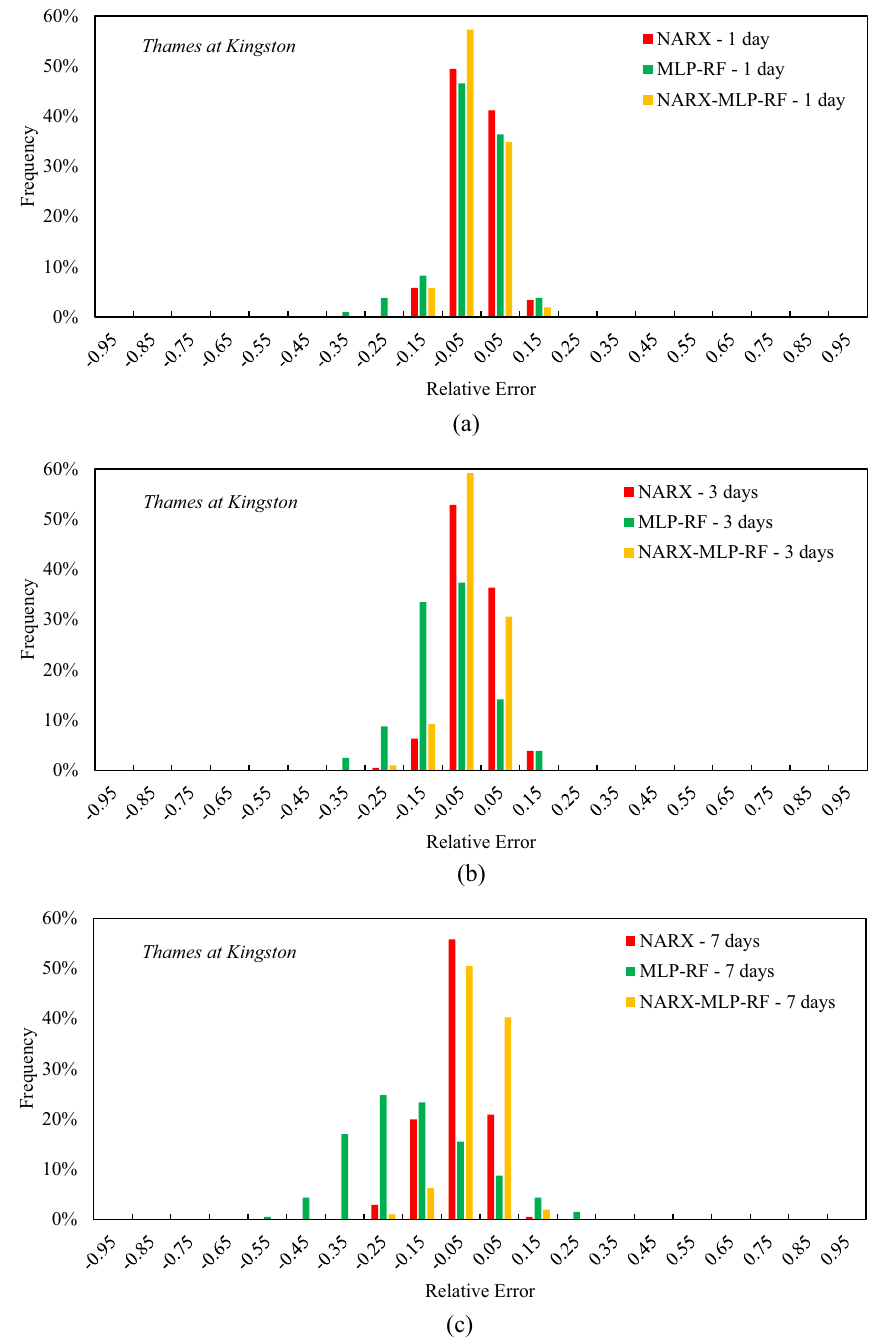
Figure 13. Frequency of the relative error for the tenth decile for Thames at Kingston: t = 1 day ( a ); t = 3 days ( b ); t = 7 days ( c